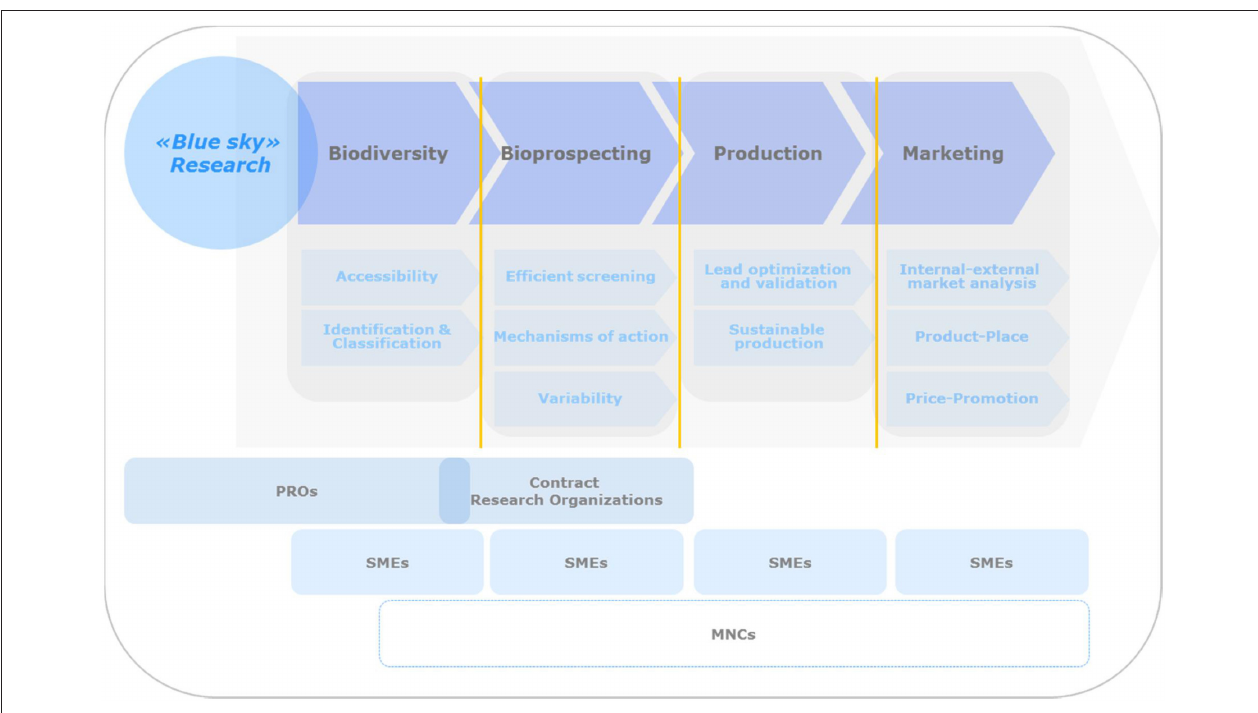
FIGURE 6 | The value